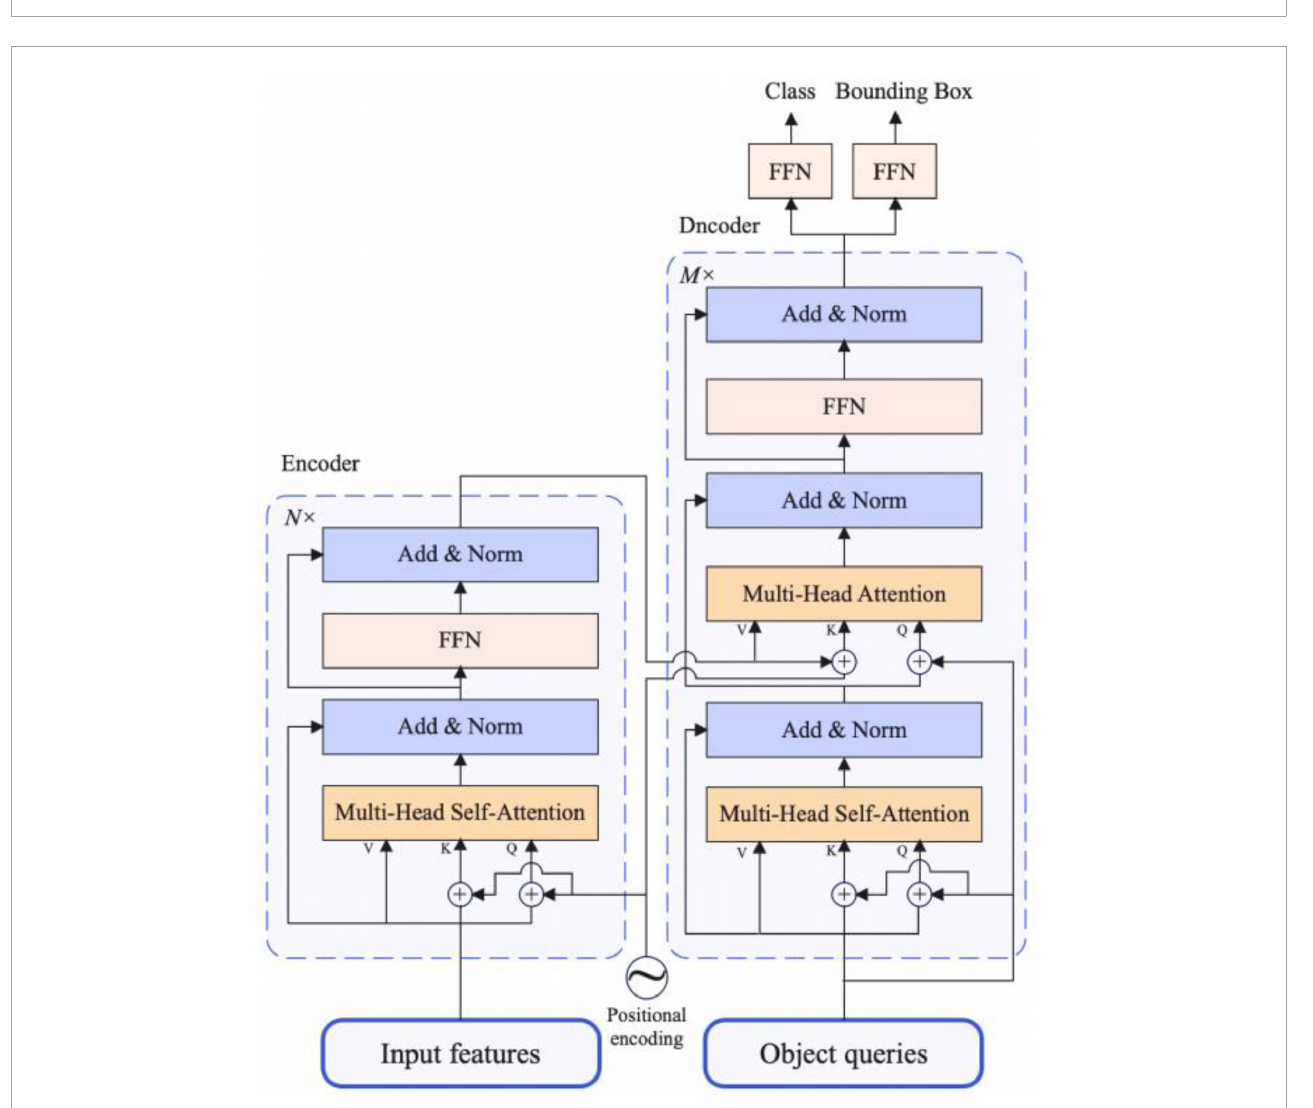
FIGURE3 The architecture of transformer encoder and